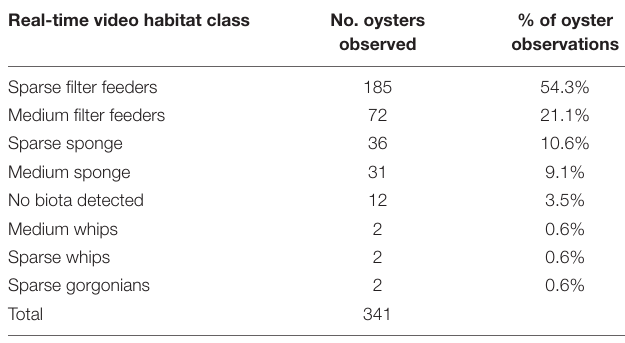
TABLE 1 | Percent of habitat classes observed in the same locations as oysters on real-time towed video transects (including observations that were discarded due to missing bathymetry